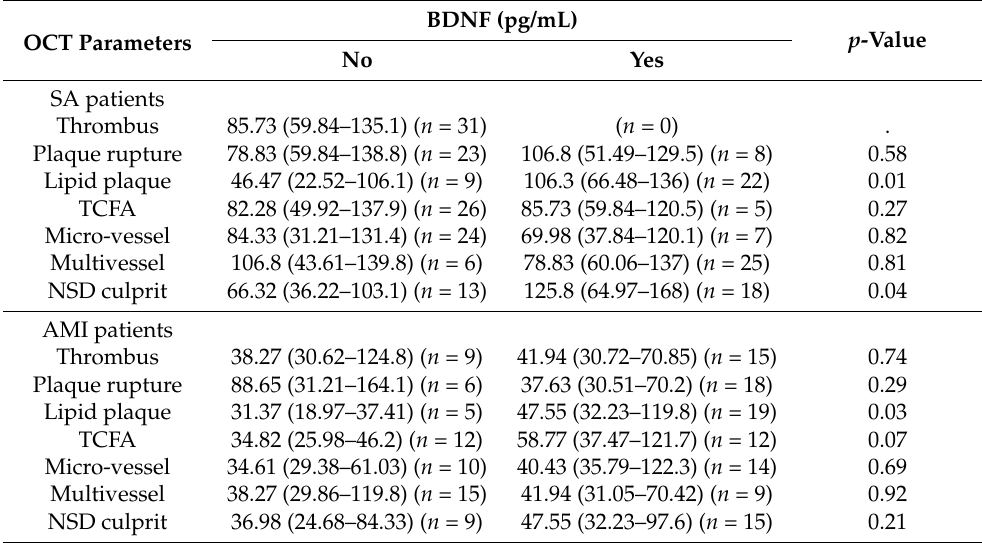
Table 3. Plasma BDNF levels according to OCT features in SA and AMI patients